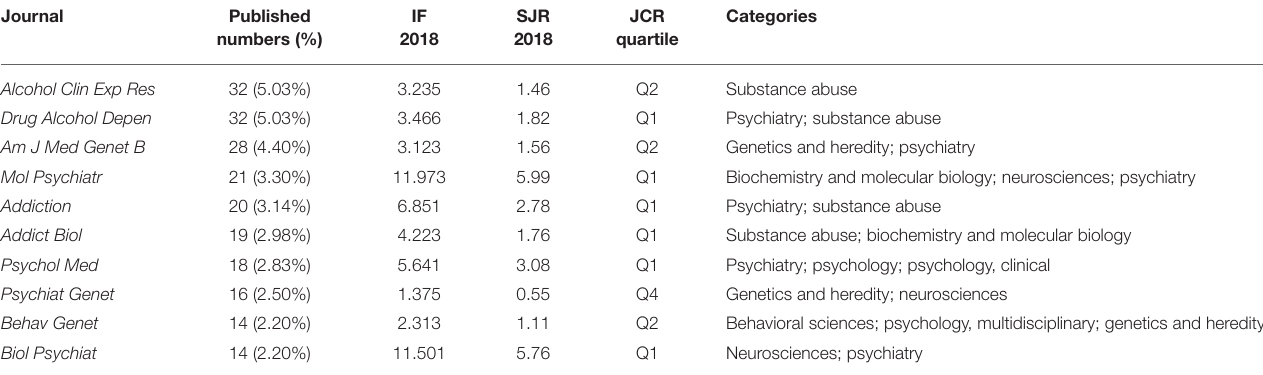
TABLE 2 | The 10 most active journals that published articles on substance-related disorders